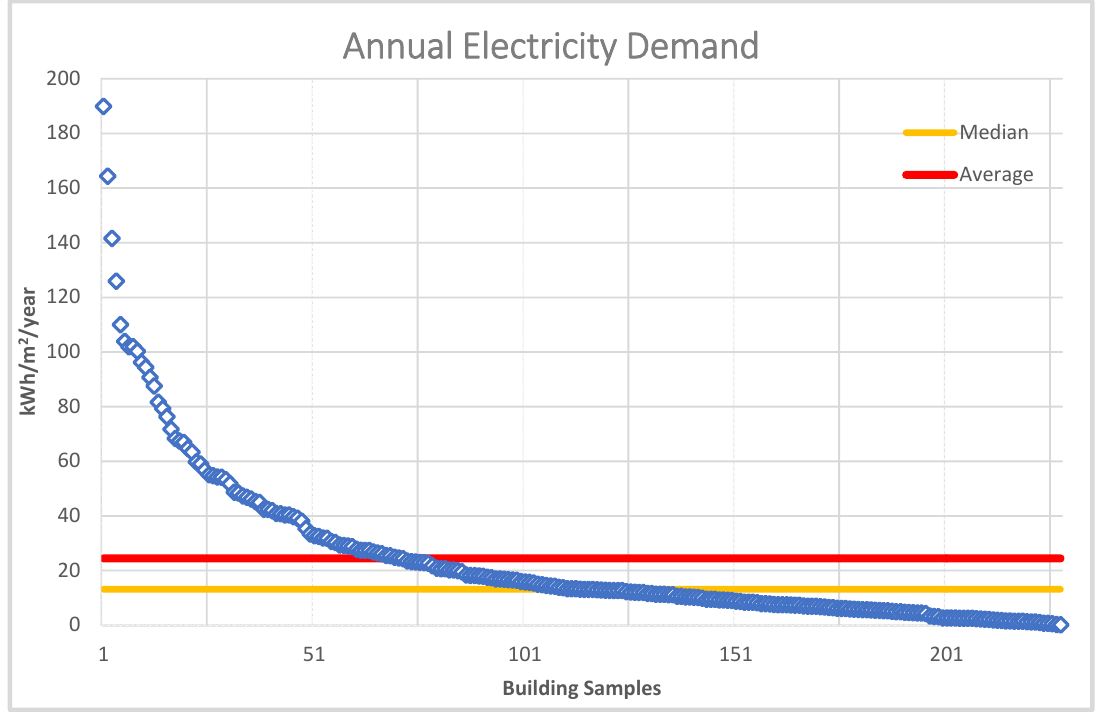
Figure 4. Annual electricity demand for building samples.